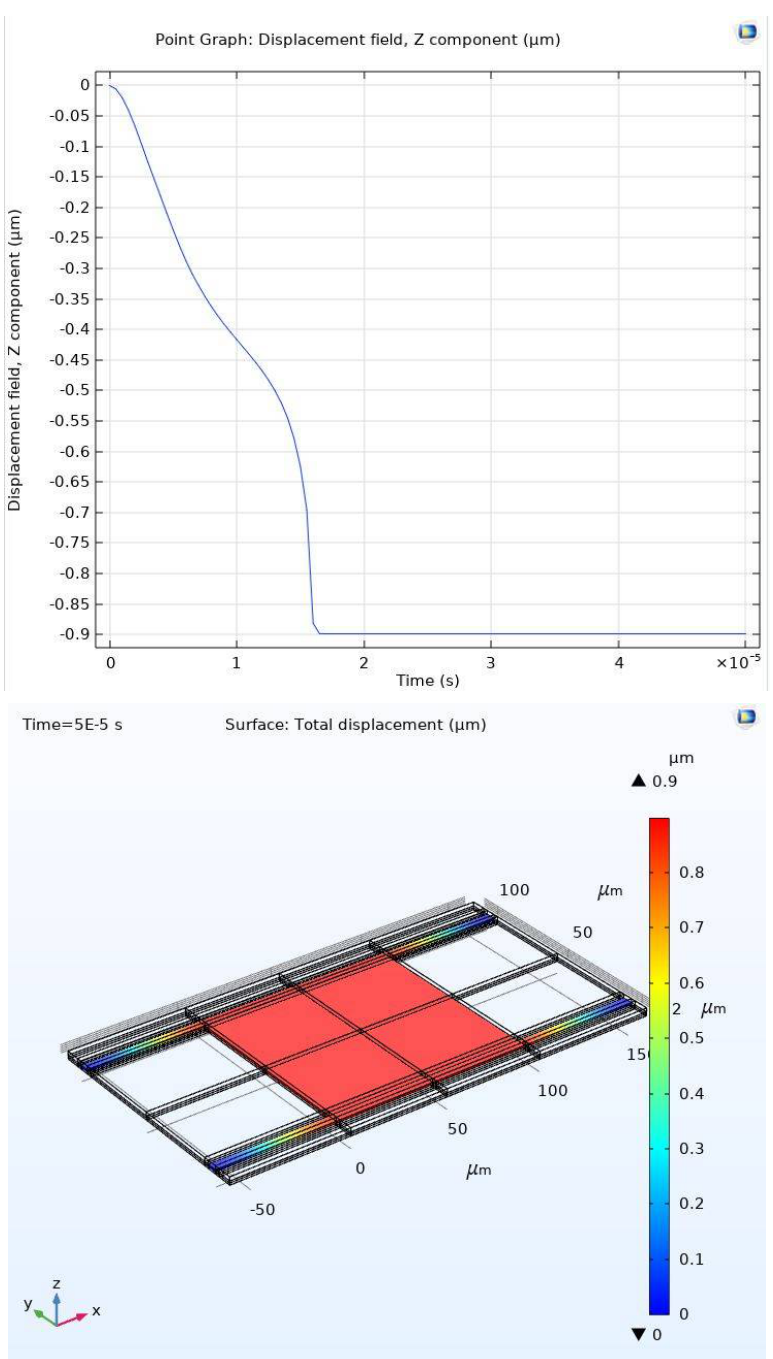
Figure 16. Stabilization at the last third of the full gap: top graph (1-D), bottom graph (3-D). Finally, Figure 17 shows the voltage (electric potential (V)) as the control input that actuates the RF MEMS device and moves the upper plate in the z coordinate towards the fixed plate (for the 2 positions above). As expected from the theory, a higher voltage signal (around 4.5 V) was needed to move the plate to the 0.9 µ m position (near the fixed plate) compared to around 2.5 V that was